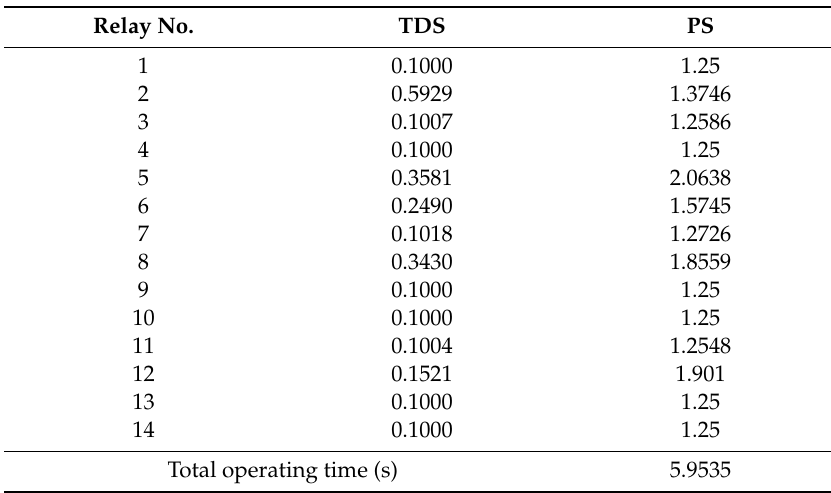
Table 6. Optimal TDS for the IEEE eight-bus